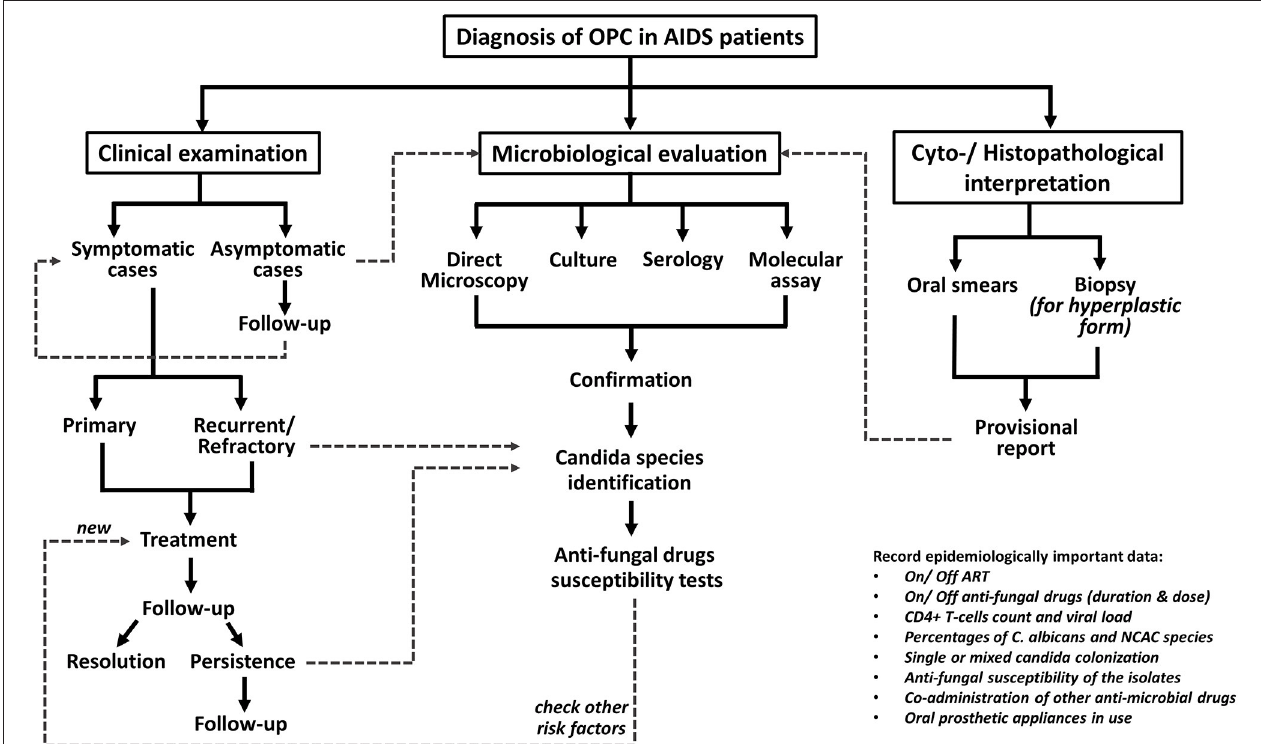
FIGURE 1 | Diagnostic protocol for oropharyngeal candidiasis in HIV-positive patients.